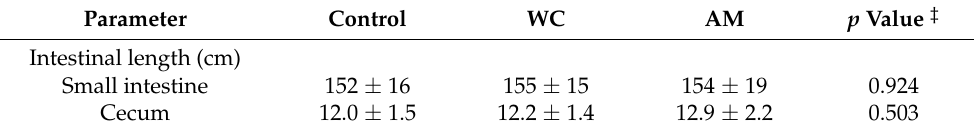
Table 2. Cont. Parameter Control WC AM p Value ‡ Intestinal length (cm) Small intestine 152 ± 16 155 ± 15 154 ± 19 Cecum 12.0 ± 1.5 12.2 ± 1.4 0.503